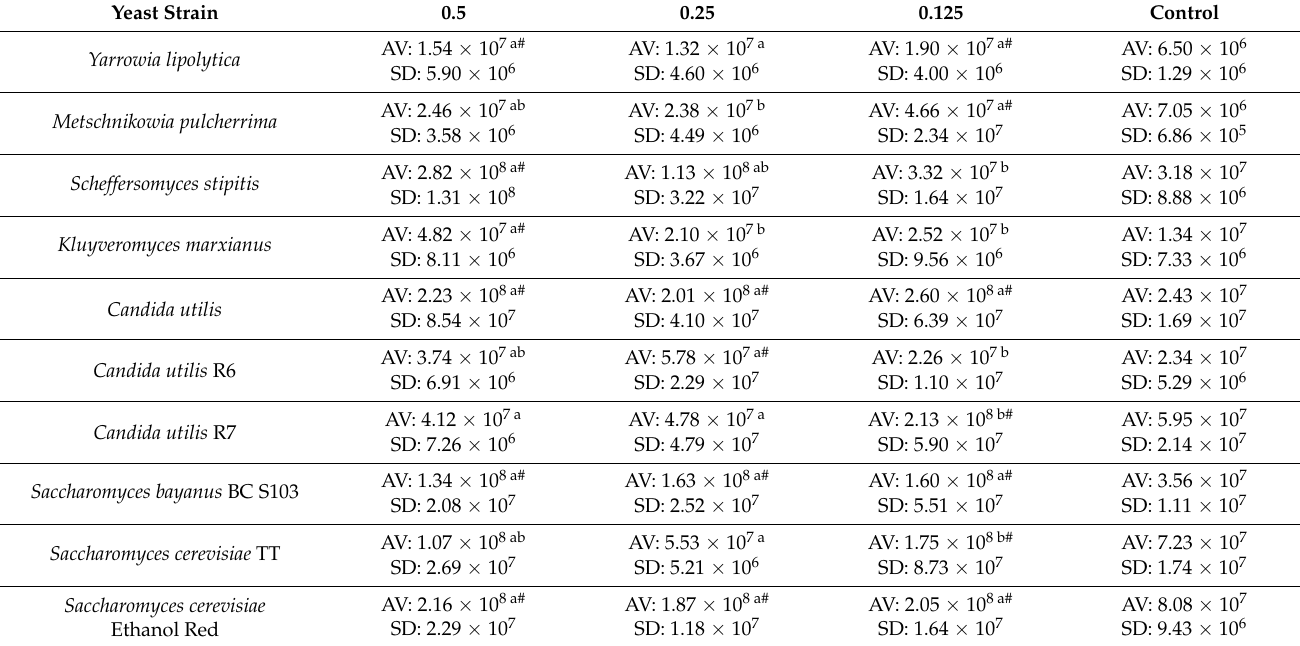
Table 2. Yeast growth [CFU/mL] in a culture medium with fresh sugar beet pulp pretreated by enzymatic hydrolysis with various enzyme doses A–C [ml/10 g of dry